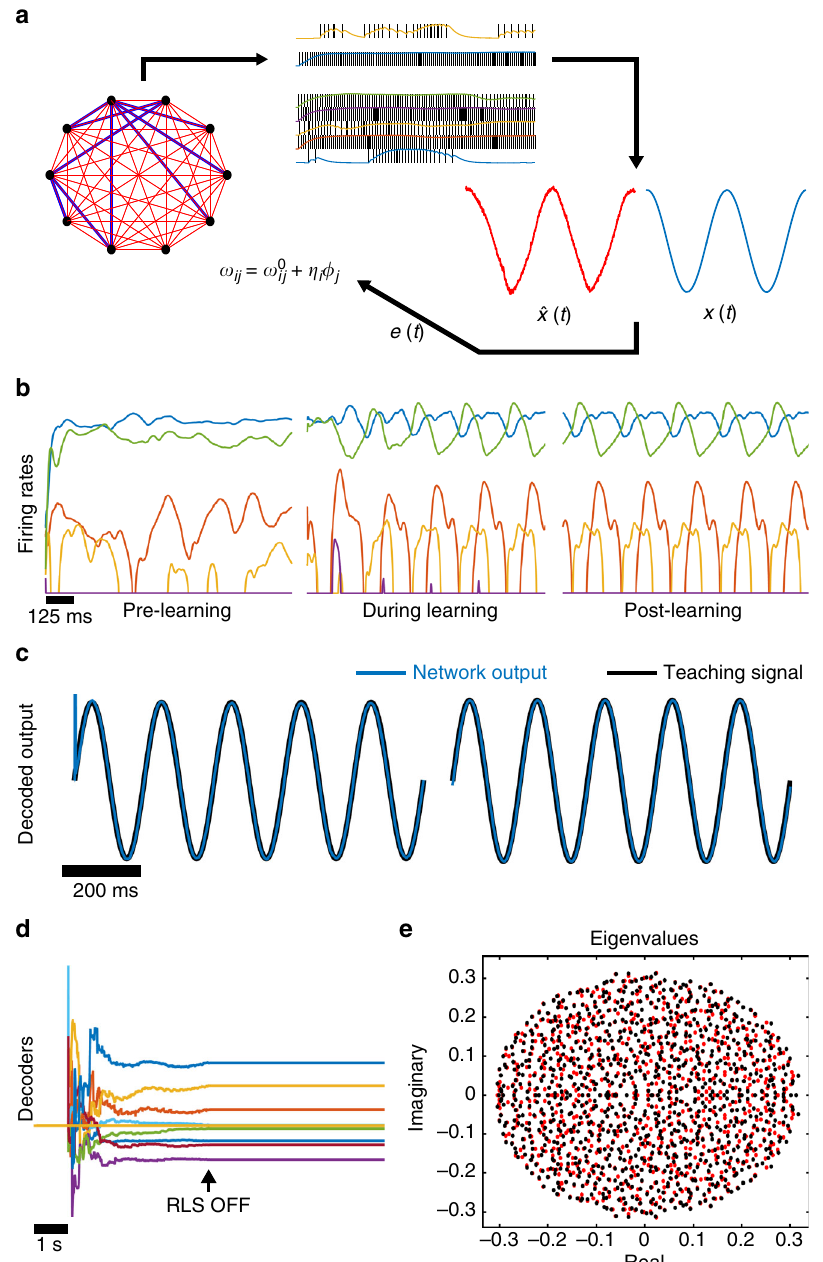
Fig. 1 The FORCE method explained. a In the FORCE method, a spiking neural network contains a backbone of static and strong synaptic weights that scale ffiffiffiffi p N like 1 = to induce network level chaos (blue). A secondary set of weights are added to the weight matrix with the decoders determined through a time optimization procedure (red). The Recursive Least Squares technique (RLS) is used in all subsequent simulations. FORCE training requires a supervisor x ( t ) to estimate with ^ x ð t Þ . b Prior to learning, the fi ring rates for 5 random neurons from a network of 1000 rate equations are in the chaotic regime. The chaos is controlled and converted to steady-state oscillations. c This allows the network to represent a 5 Hz sinusoidal input (black). After learning, the network (blue) still displays the 5 Hz sinusoidal oscillation as its macroscopic dynamics and the training is successful. The total training time is 5 s. d The decoders for 20 randomly selected neurons in the network, before ( t < 5), during (5 ≤ t < 10) and after ( t ≥ 10) FORCE training. e The eigenvalue spectrum for the effective weight matrix before (red) and after (black) FORCE training. Note the lack of dominant eigenvalues in the weight